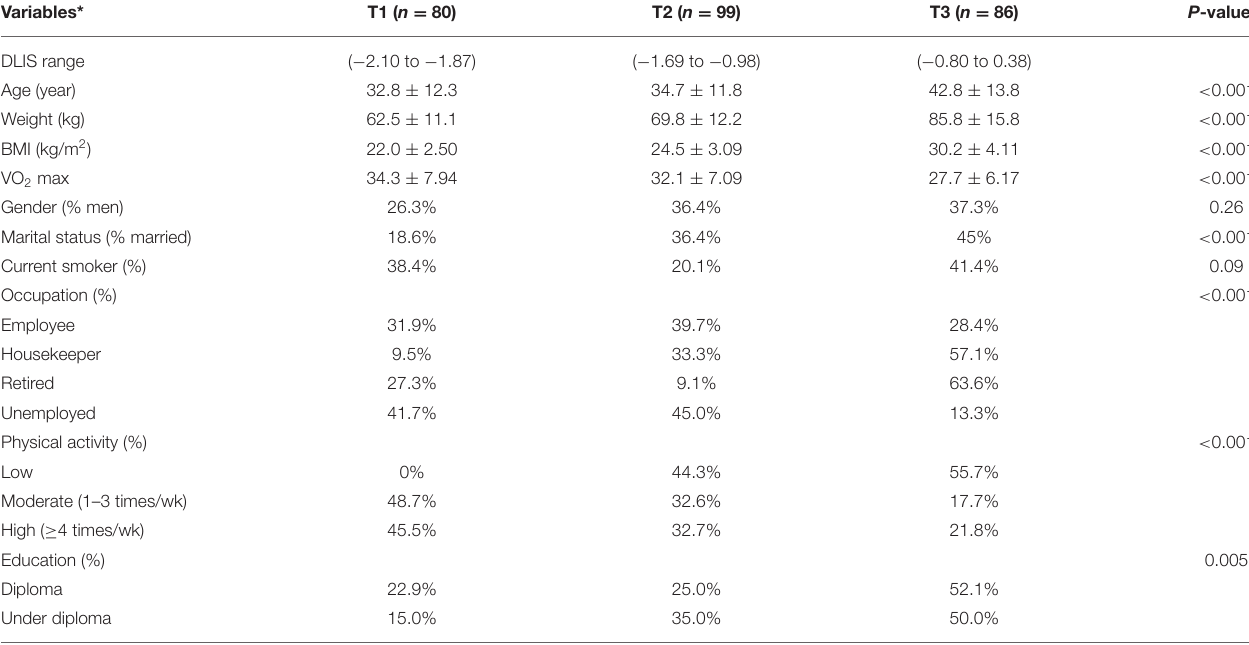
TABLE 1 | Characteristics of the study participants across tertiles of the DLIS ( n = 265).